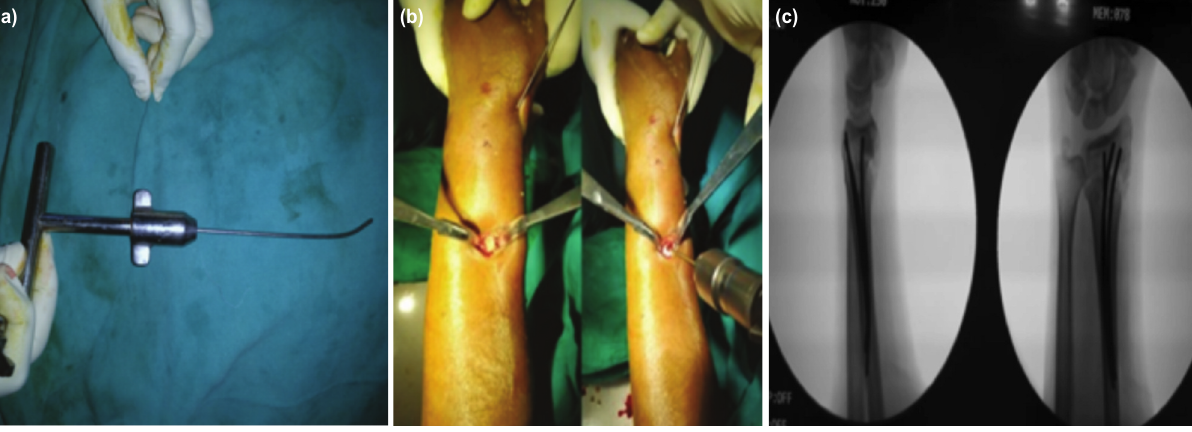
(a) Images showing a pre-bent wire prior to insertion, (b) exposure and drilling of radius for antegrade placement of wires, (c) Fig. 2: and AP and lateral radiographs after final placement of the